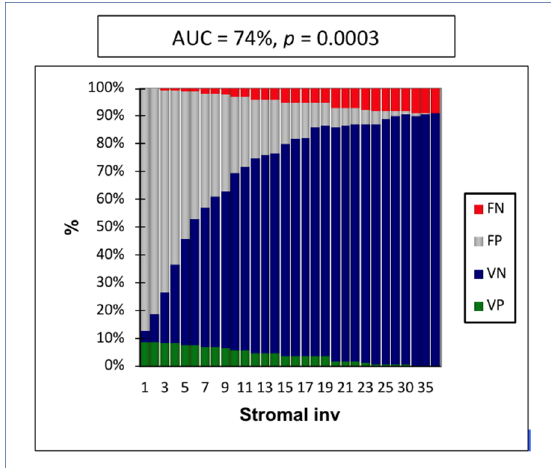
Figure 2. Stromal invasion and the presence of low-volume metastasis. FN = false negative, FP = false positive, VN = true negative, VP = true positive, AUC = Area under the Curve.